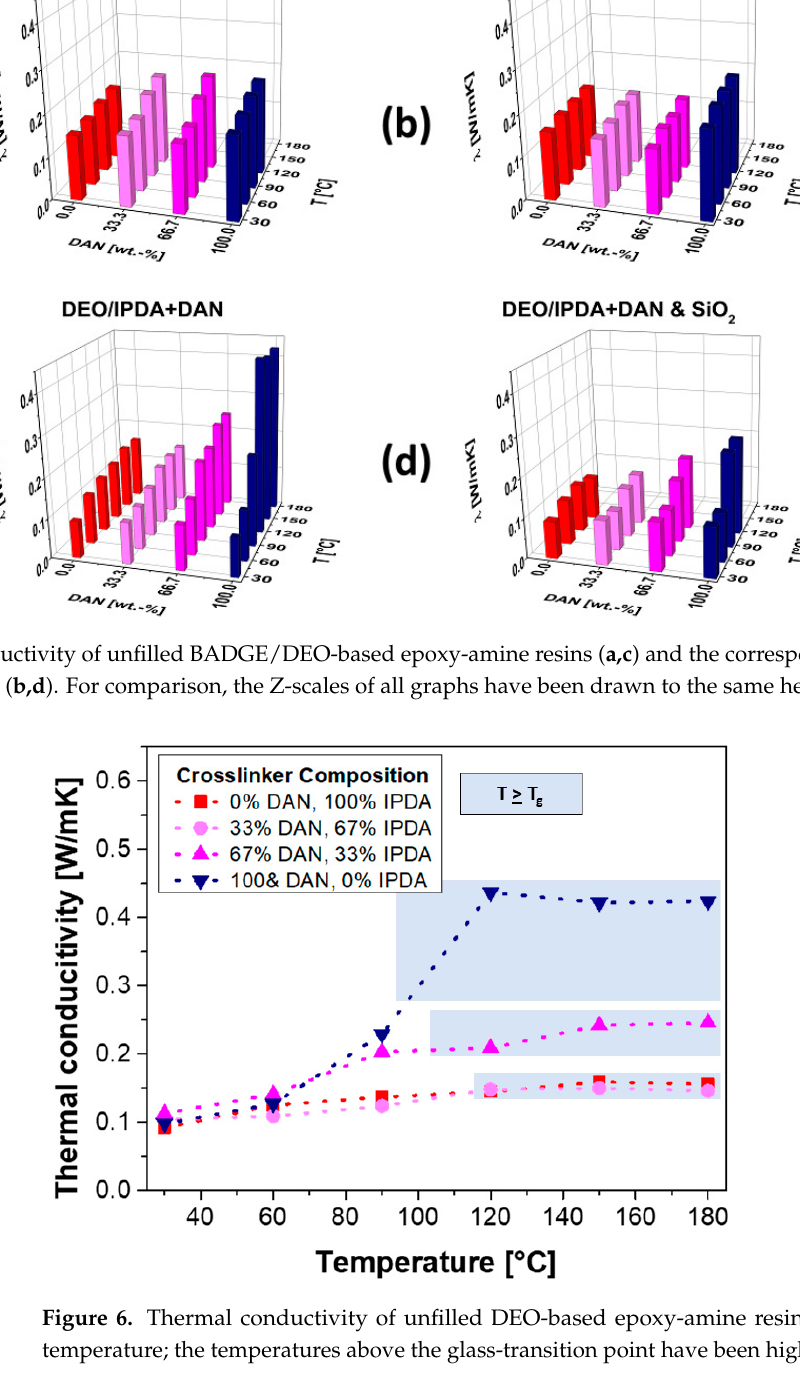
Figure 6. Thermal conductivity of unfilled DEO-based epoxy-amine resins as a function of the temperature; the temperatures above the glass-transition point have been highlighted in blue shade.